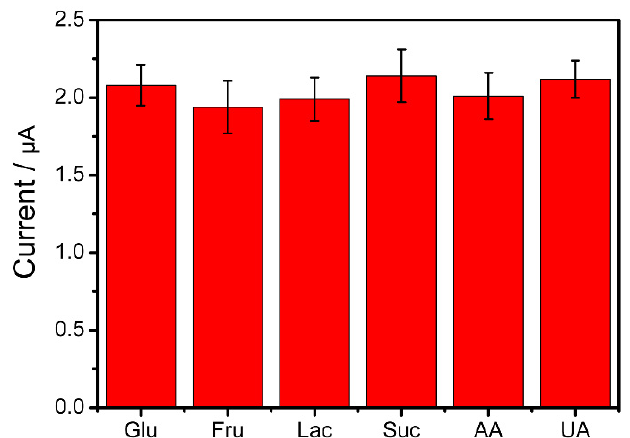
Figure 8. Specificity of the glucose sensor examined by addition of several interferents to GLU solution. Each error bar represents the standard deviation with n = 4.